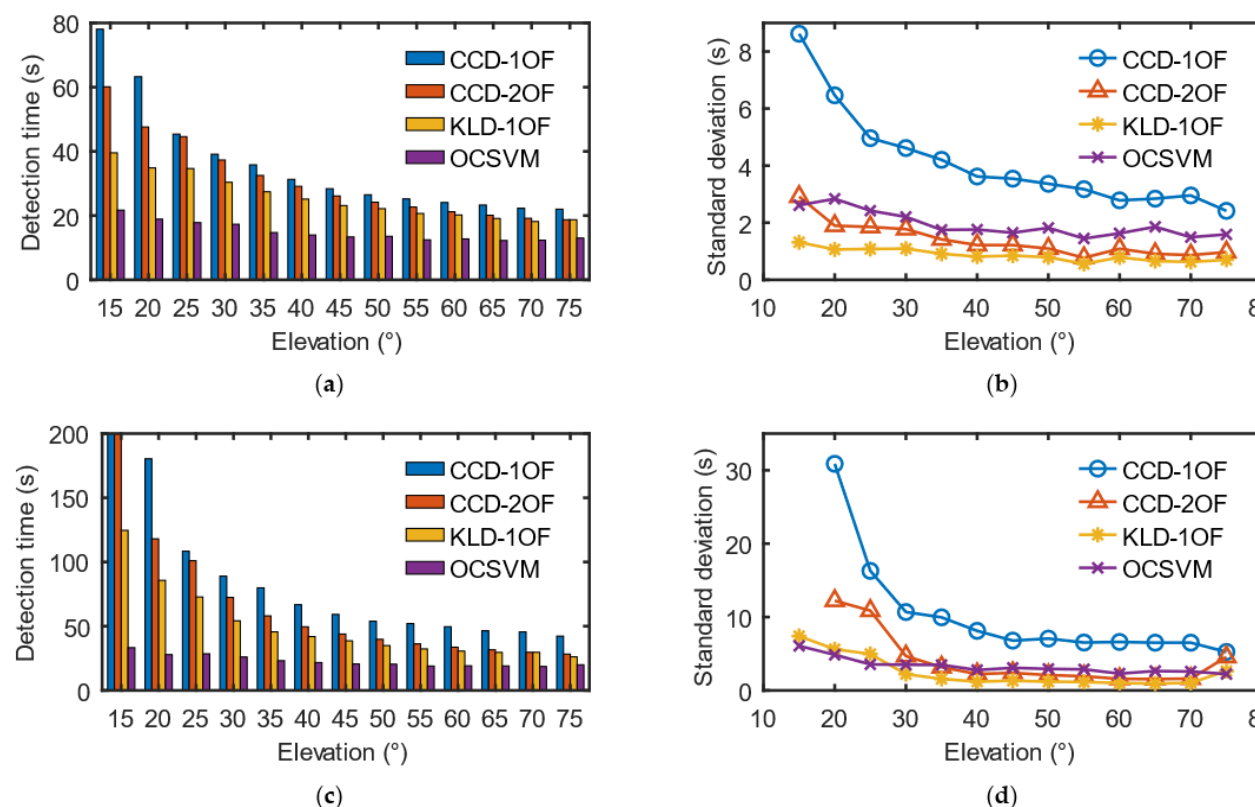
Figure 14. Comparison of the average and the standard deviations of the detection time when applying the CCD-1OF, CCD-2OF, KLD-1OF and the proposed OCSVM-based monitors to detect the ionospheric anomaly on PRN7. The ionospheric gradients, with the change rate set to 0.01 m/s in ( a , b ) and 0.02 m/s in ( c , d ), are inserted.